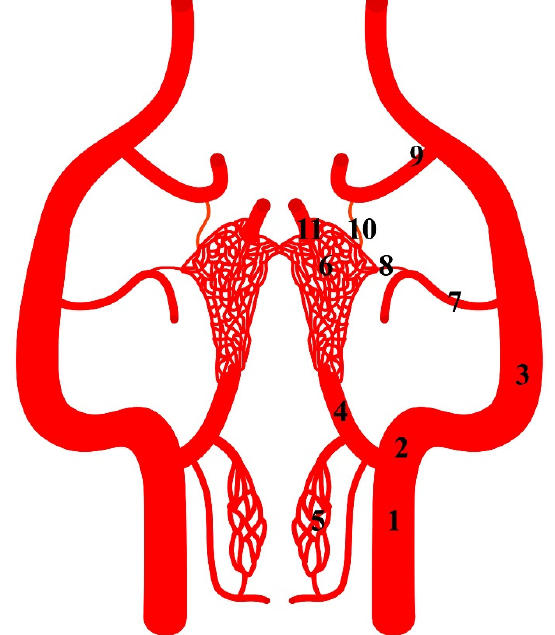
Figure 1. Diagram of the arterial pattern in the Eurasian wild boar ( Sus scrofa ). 1—common carotid